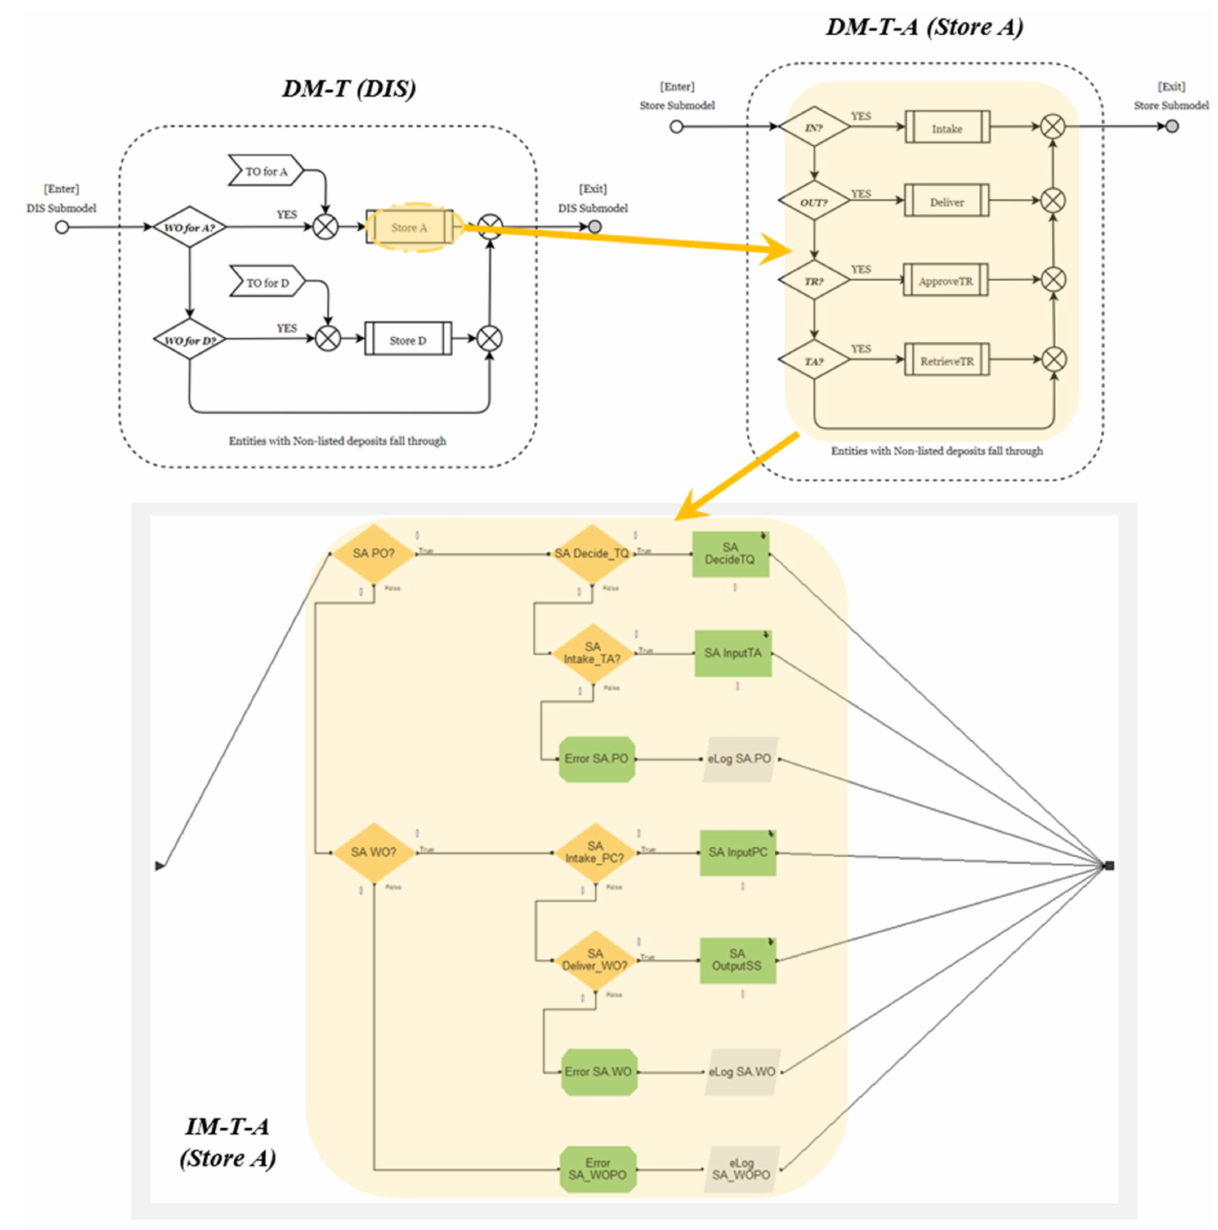
Figure 25. Conversion of DM-T-A into IM-T-A sub-model highlighted in beige. Top left is DM-T and top right sub-model DM-T-A (both detailed in Figure 21). The diagram shows the relationship be- tween the sub-models. The details of the individual models are not relevant to the present